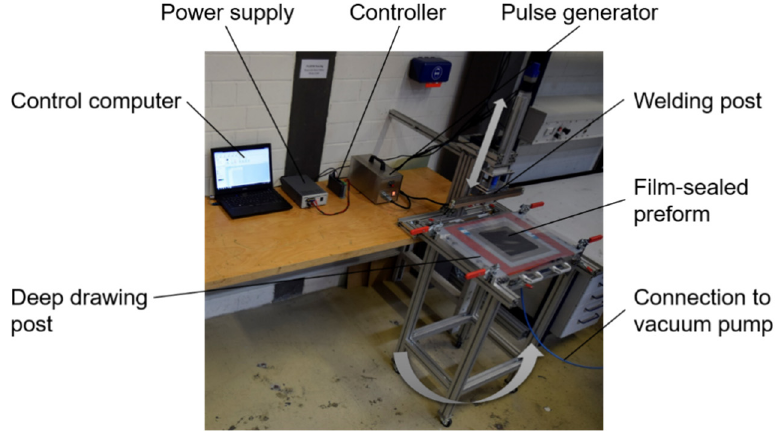
Figure 5. Components of the film-sealing station for preforms.